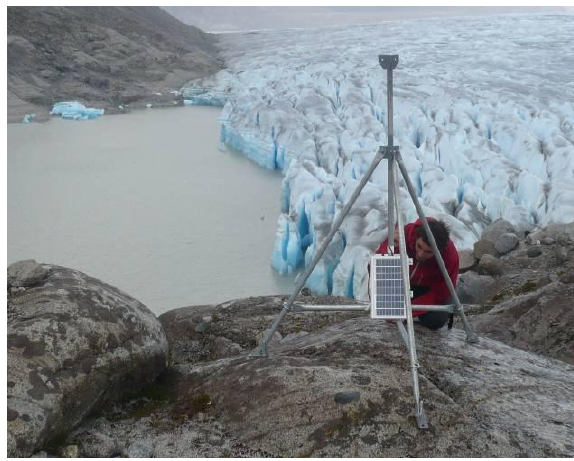
Figure 8. Time lapse camera system installation at Lago Nef Norte (Maas et al., 2012)